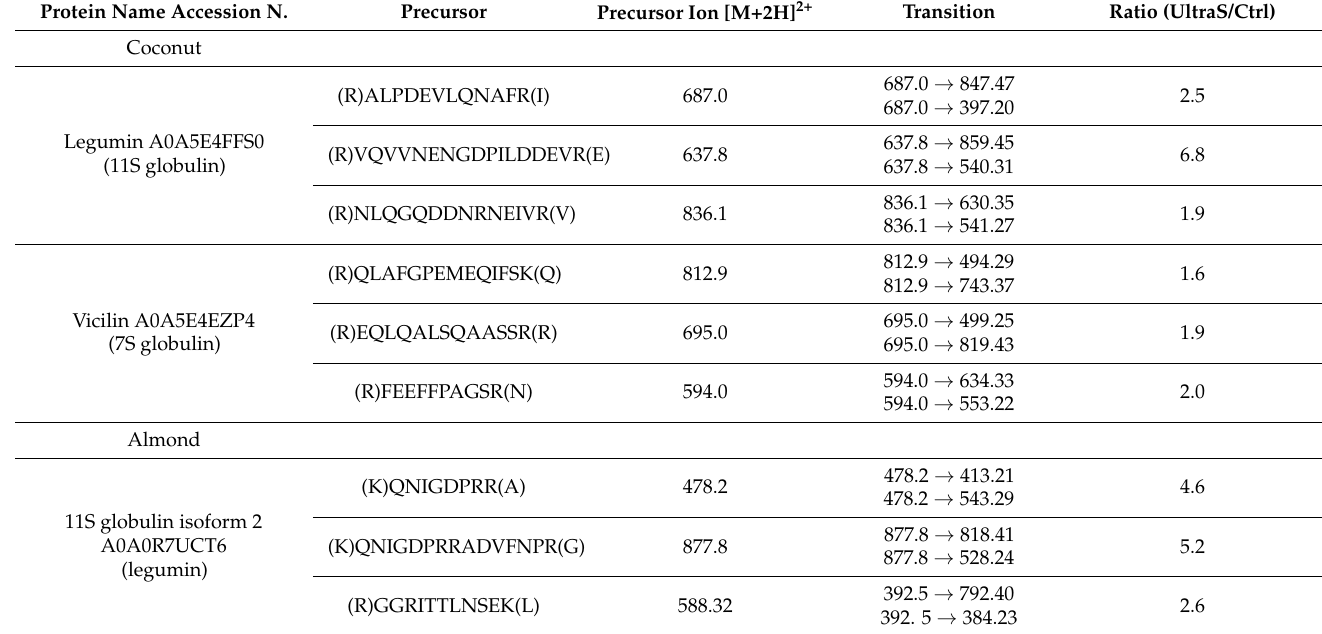
Table 1. Transition list of selected peptides for relative protein quantification of most abundant protein identified in coconut and almond